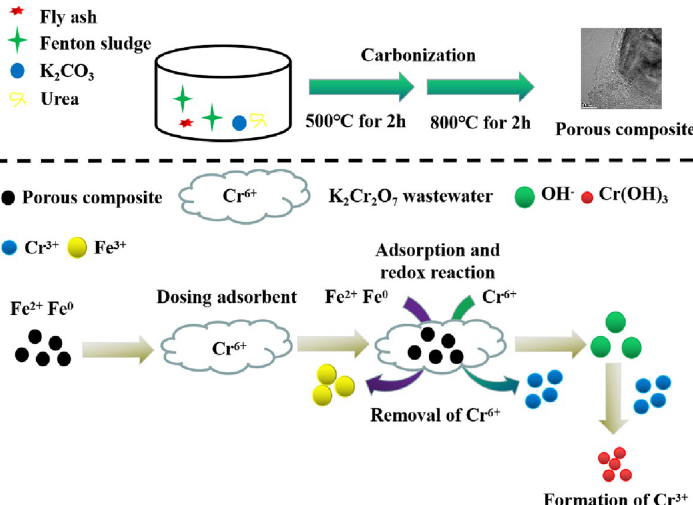
Figure 7. Reaction mechanism